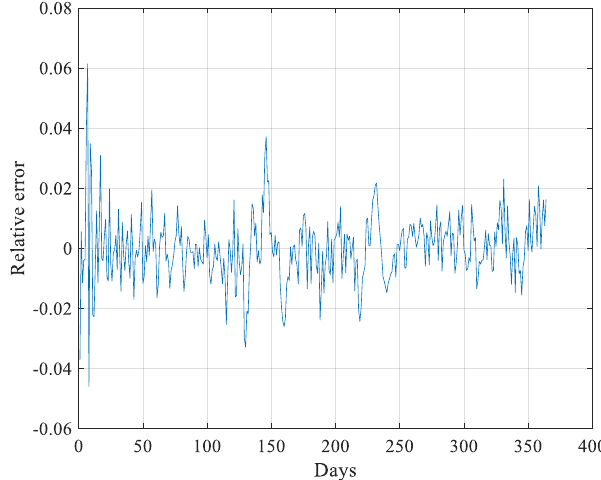
Figure 14. Relative error diagram of reconstructed signal.